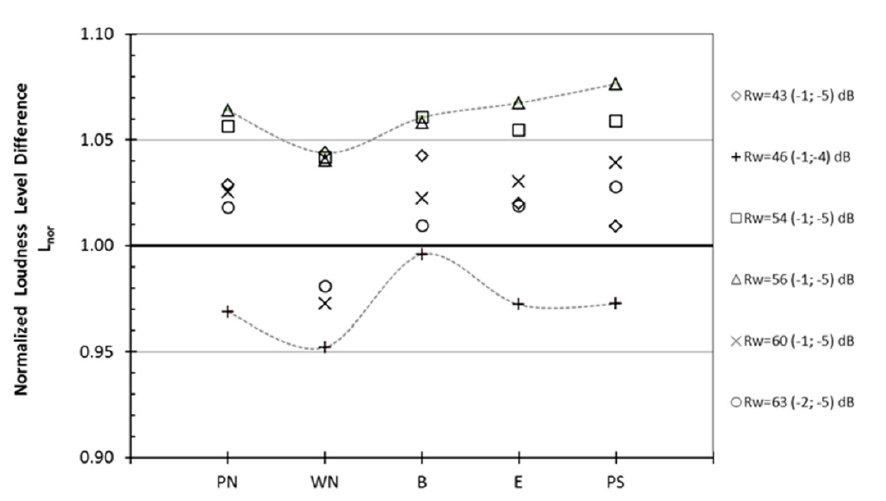
Figure 3. Specific fluctuation strength ( Fls ’) as a function of sound pressure level. The shaded area characterizes the region for the specific fluctuation strength ( Fls ’).